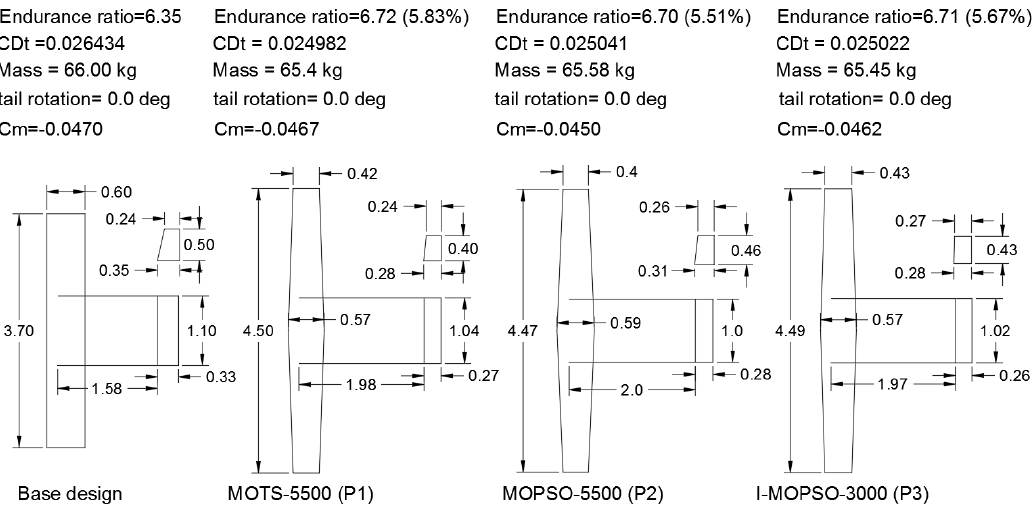
Figure 24. Comparison of detail configurations for the optimum compromise solutions obtained using MOTS for 5500, MOPSO for 5500, and I-MOPSO for 3000 with Aegis UAV base design.